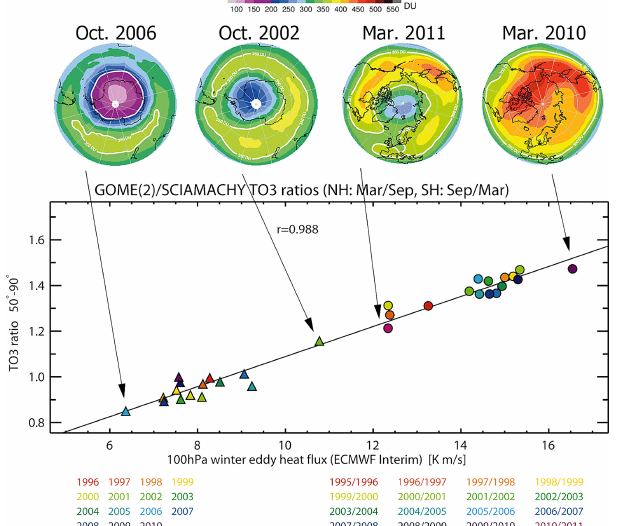
Fig. 3. Correlation between winter mean eddy heat flux and spring- to-fall ozone ratio over the polar caps (update from Weber et al., 2011). Triangles are data from the SH; circles from the NH. The winter mean eddy heat flux is calculated by averaging the monthly mean eddy heat flux from 43 to 75 ◦ , separately, in each hemisphere and average over the months September–March in the NH (for NH data) and March–September in the SH (for SH data).